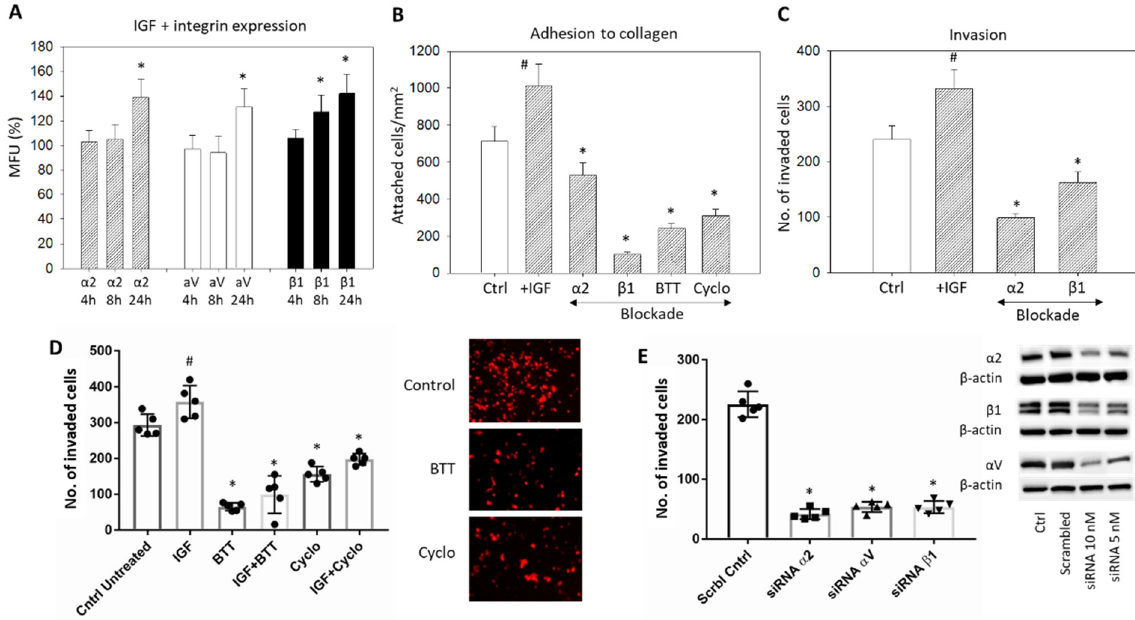
Figure 6. ( A ) IGF1 stimulated expression of the integrins α 2, β 1, and α V in HepG2 cells, evaluated after 4, 8, and 24 h. The figure depicts fluorescence intensity, related to untreated controls set to 100%. * significant difference ( n = 3); ( B ) HepG2 cell adhesion to immobilized collagen after stimulation with IGF1 plus blockade with specific antibodies targeting α 2 or β 1, α 2 β 1 (BTT) or α V (Cyclo). Controls remained untreated. Mean adhesion +/ − SD is shown. # significant upregulation, * significant downregulation, compared to the untreated controls ( n = 4); ( C ) Invasion of HepG2 cells after stimulation with IGF1 plus blockade with specific antibodies targeting α 2 or β 1. Cell number is related to untreated controls; ( D ) Invasion of HepG2 cells (mean +/ − SD) after stimulation with IGF plus blockade by BTT (blockade against α 2 β 1) and Cyclo (blockade against α V β 3). Controls remained untreated. # significant difference to the untreated control, * significant downregulation to the control ( n = 3). Right panel represents stained invaded cells (x200 objective; control versus BTT or Cyclo treatment); ( E ) HepG2 cell invasion in response to α 2, β 1, or α V knockdown with small interfering RNA (siRNA) (Western blot at right).